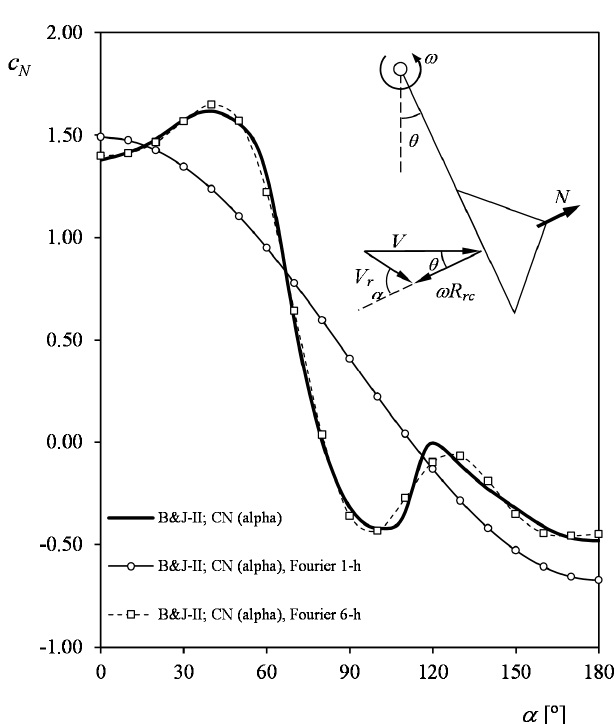
Figure 9. Normal aerodynamic force coefficient, c N , of the Brevoort & Joyner Type-II (conical) cups [77]. See in the sketch the variables involved in the rotation of an anemometer cup: normal aerodynamic force on the cup, N , wind speed, V , relative wind speed to the cup, V r , rotor rotation angle, θ , rotor rotational speed, ω , and wind direction with respect to the cup, α . The 1-harmonic term Fourier series approximation (Equation (12)) to the Type-II cup has been plotted, together with the more accurate 6-harmonic terms Fourier series